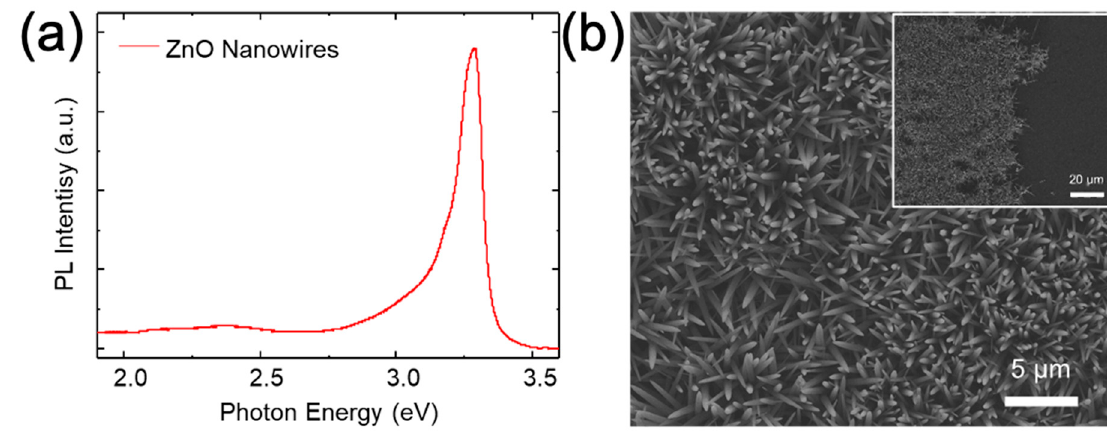
Figure 7. ( a ) RT PL spectrum of ZnO wires after the 4th cycle of the growth-etching process. ( b ) SEM images of ZnO wires grown on graphene after the 7th growth and etching cycle. The inset is a low magnification image of the ZnO wires. There was no growth of ZnO wires on SiO 2 layer.